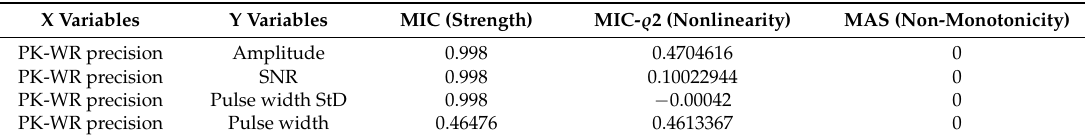
Table 2. The MIC, MIC- (cid:36) 2, MAS evaluation